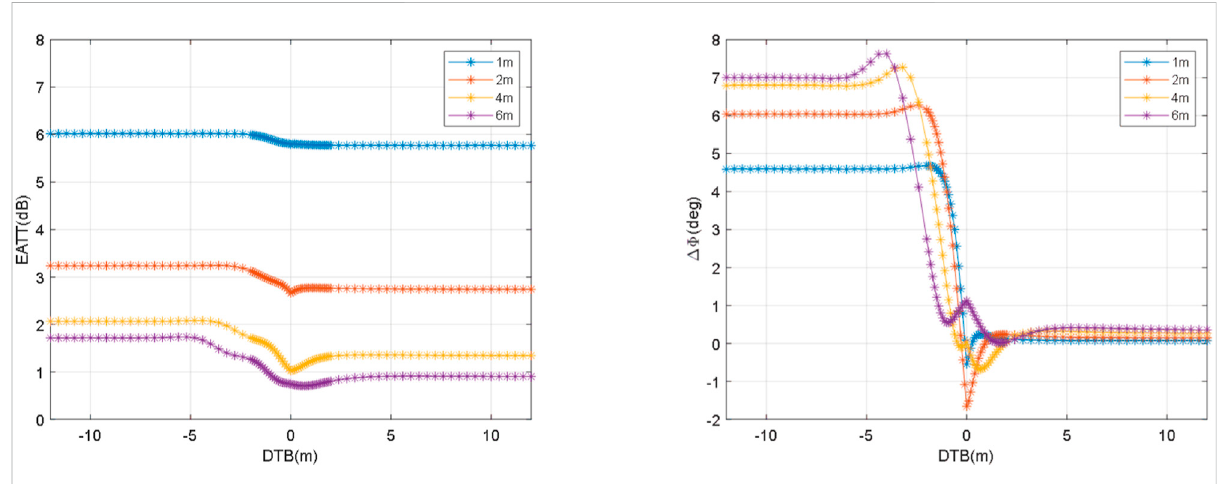
FIGURE 10 Response of the axial receiver at different source distances.